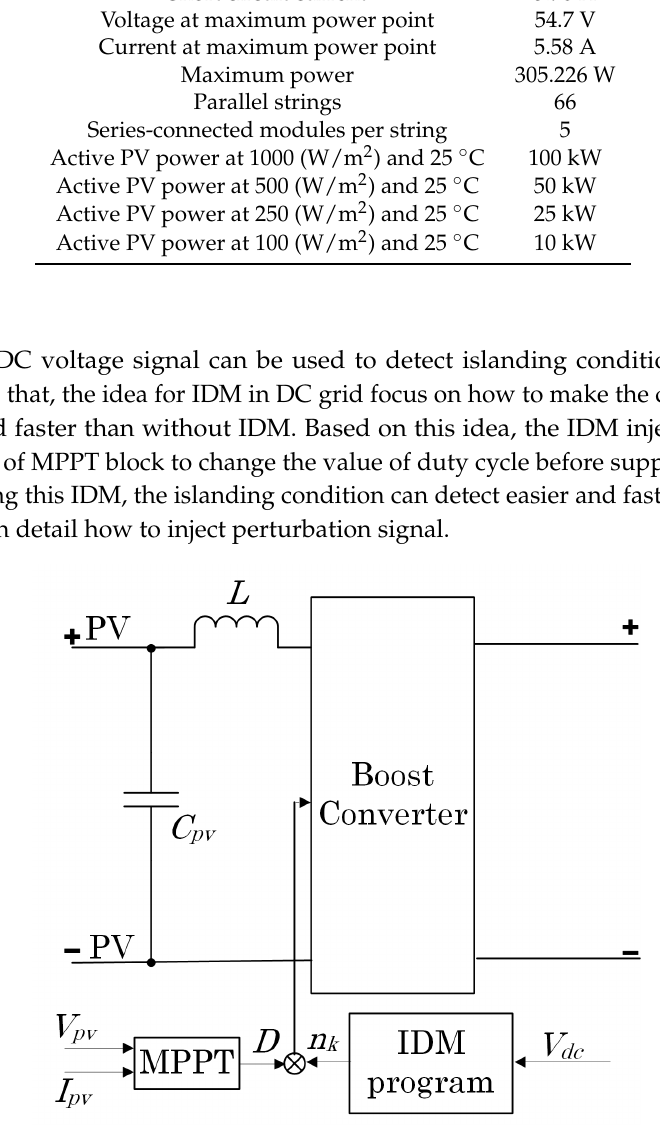
Figure 6. Controller perturbation signal circuit ( V dc is the measurement DC bus voltage, V pv is the PV voltage and I pv is the PV current, n k is the perturbation factor, D is the duty